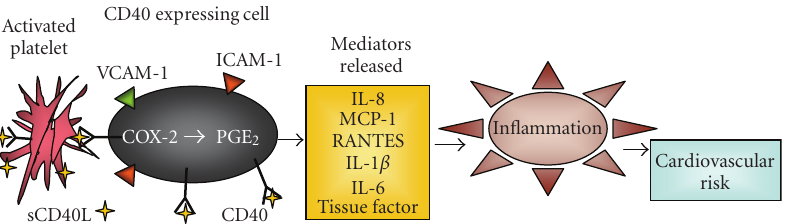
Figure 1: Platelets promote inflammation. CD40 expressing cells, such as endothelial cells or fibroblasts, can be activated by platelet-derived CD40L. CD40 signaling upregulates bioactive mediators in these cells; therefore, potentiating inflammation and increasing the risk for